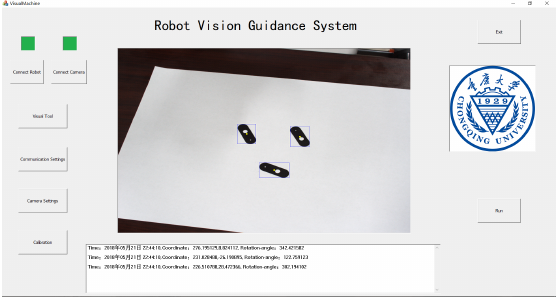
Figure 15. Result of the